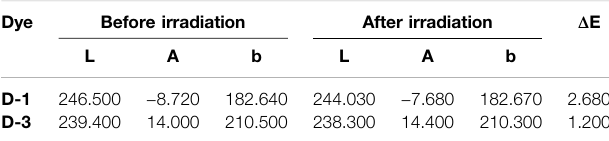
TABLE 1 | Color change ( Δ E) of two formulated dyes before and after accelerated irradiation. Dye Before irradiation After irradiation Δ E